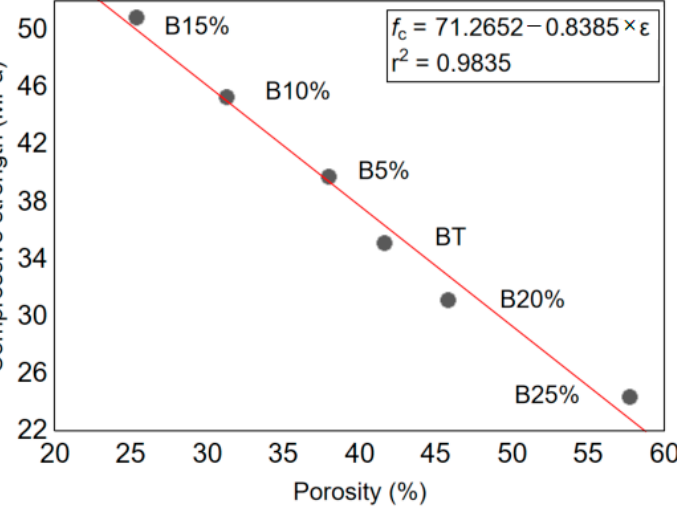
Figure 8. Correlation between the porosity and the compressive strength of the concrete with waste glass powder admixture.